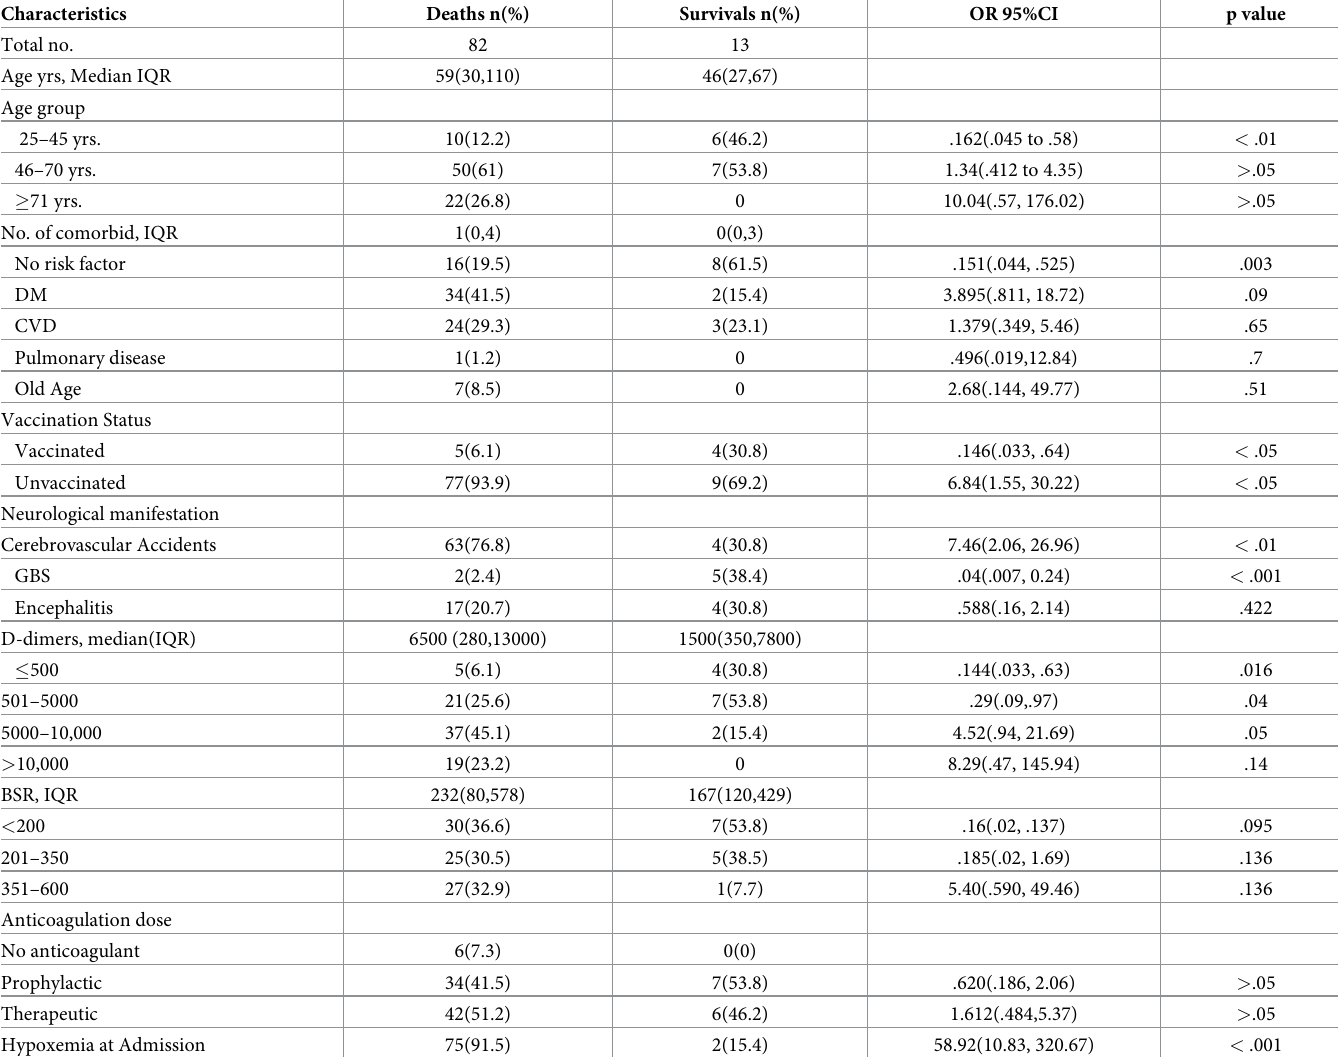
Table 2. Association between predictor variables and death outcome among patients with neurological